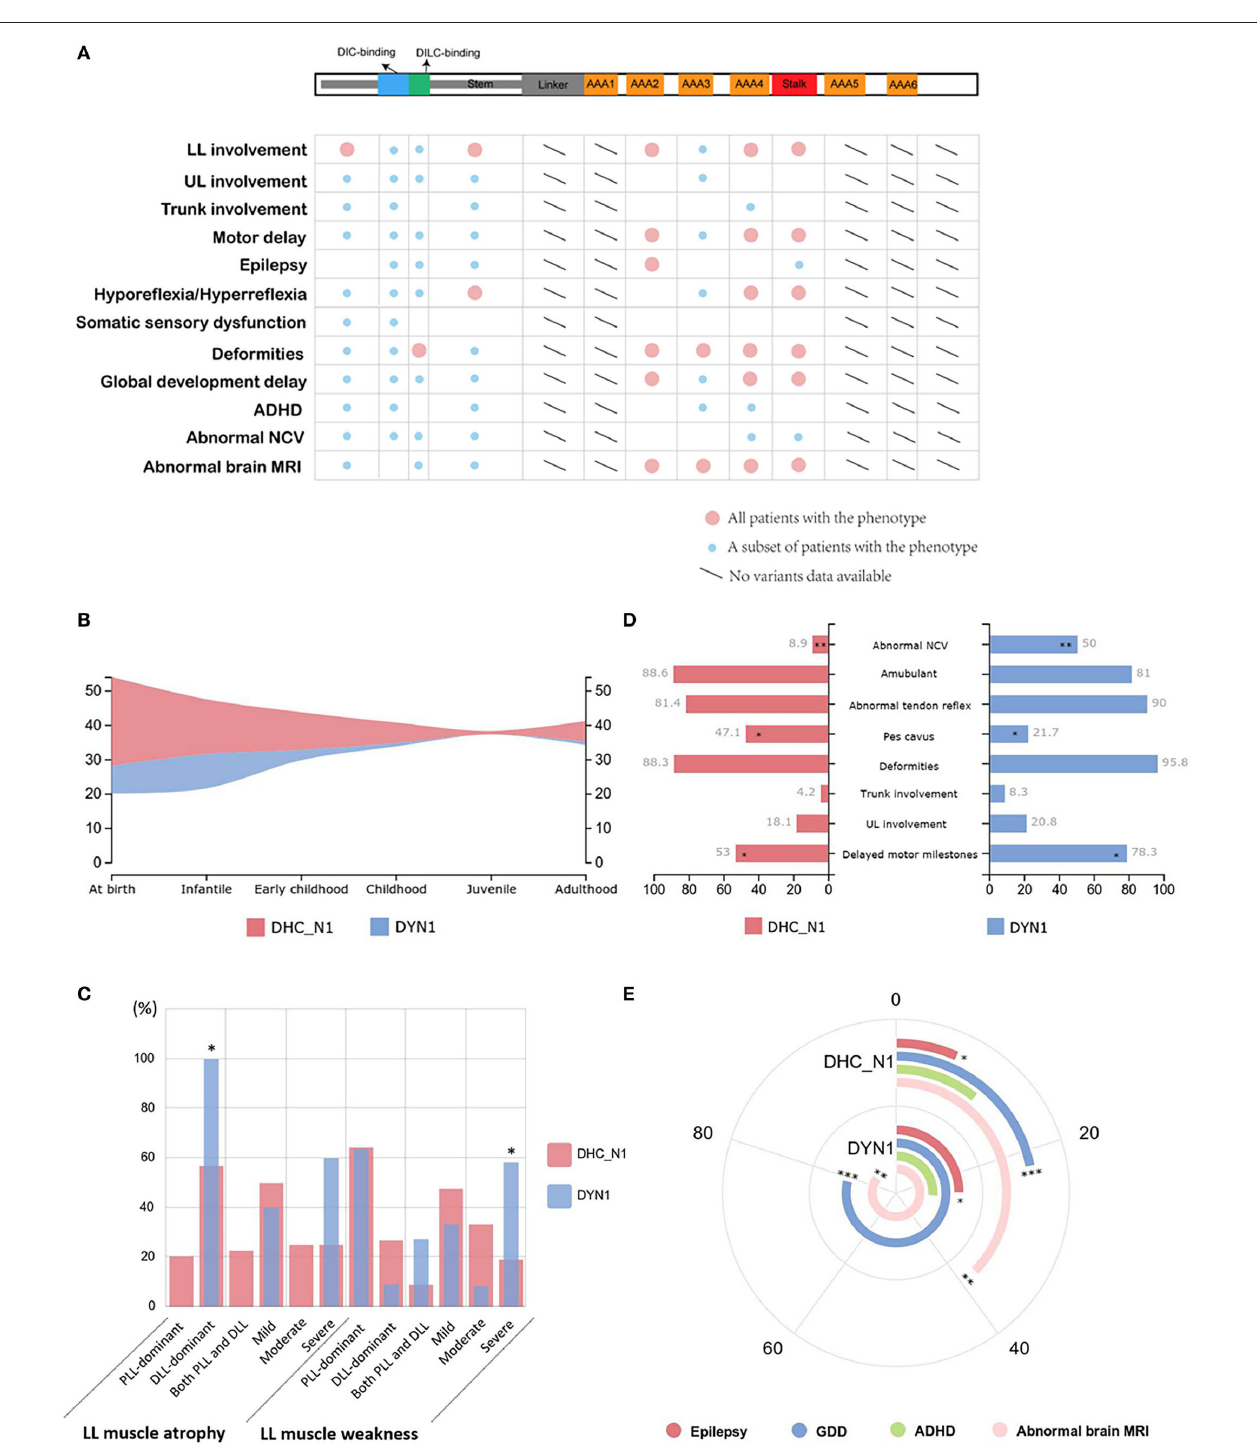
FIGURE 3 | Genotype–phenotype correlation of DYNC1H1 mutations. (A) Correlations between mutations in different domains and clinical manifestations of neuromuscular diseases. The large red circle indicates that all patients carrying DYNC1H1 mutations in a specific domain have the relevant phenotype labeled on the left side. The small blue circle refers to a small subset of patients who have the phenotype. (B) Comparison of the distribution pattern of onset age between the